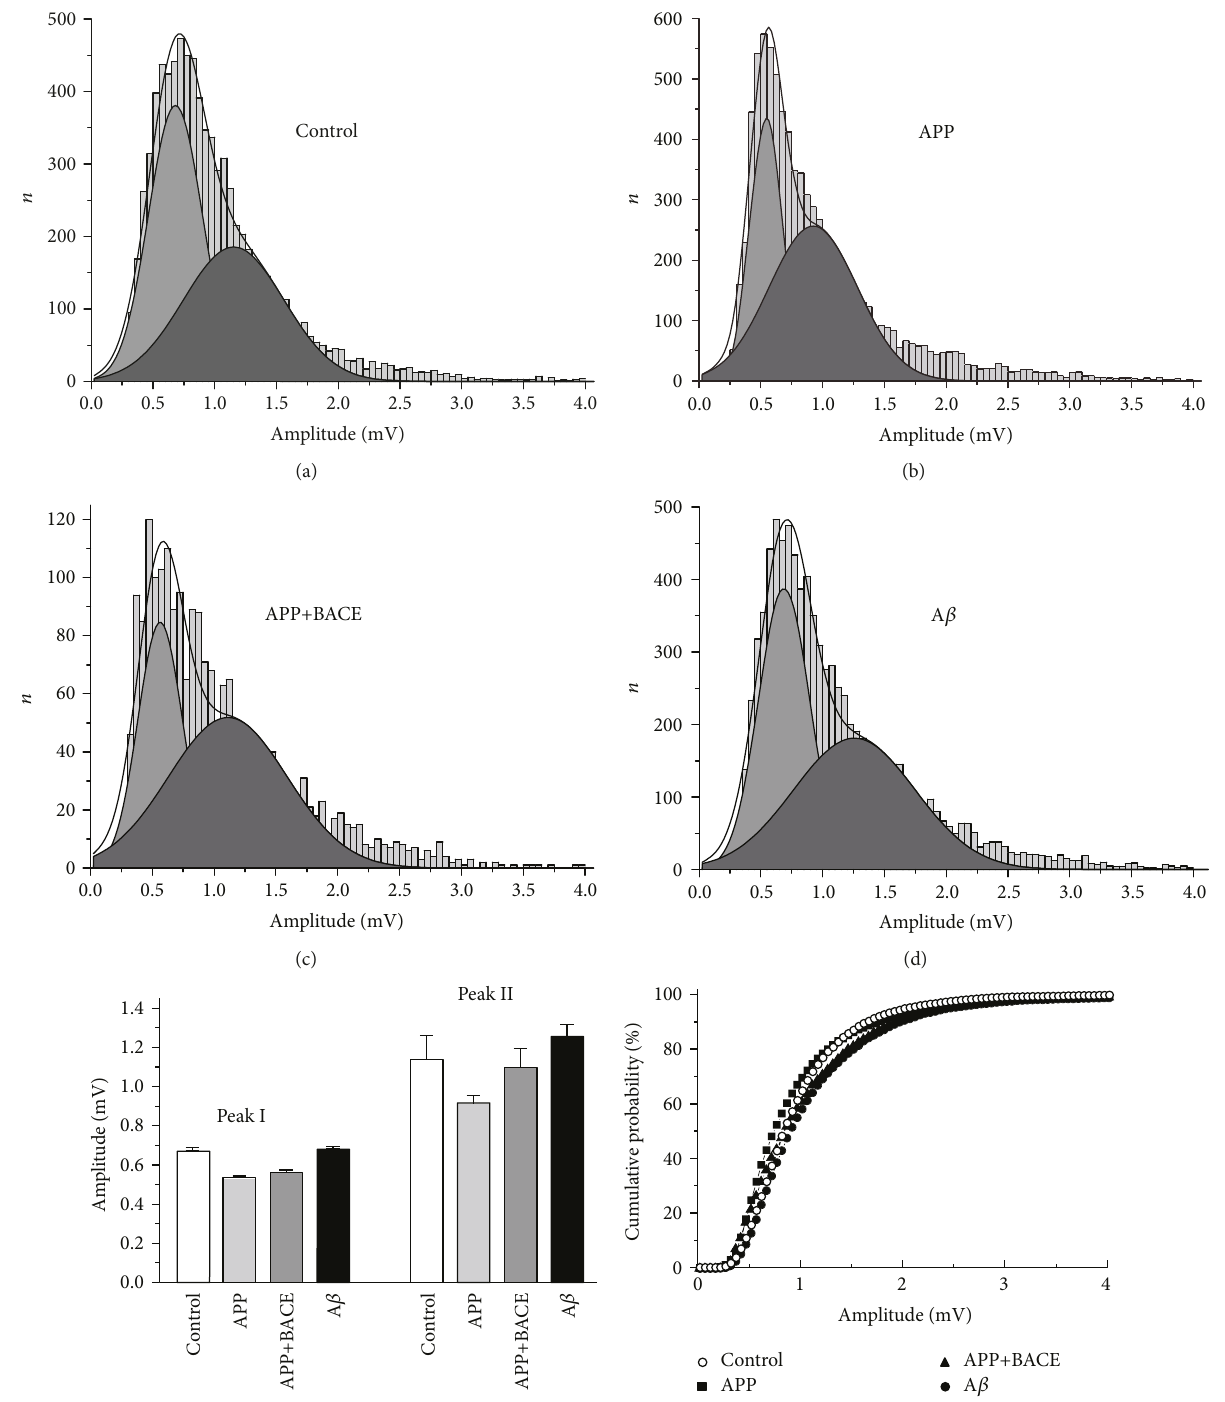
Figure 6: Distribution of mEJPs amplitudes recorded at muscle fi ber 6 and 7 neuromuscular junctions from transgenic Drosophila melanogaster larvae. (a) Control, (b) APP, (c) APP+BACE, and (d) А β lines. Amplitude histograms show similar two-peak nature of mEJPs distributions in all lines (double Gaussian fi ts are shown). (e) The average amplitude of two peaks from mEJPs amplitude distribution (a – d). (f) Cumulative histogram of the mEJPs amplitude distribution. Total mEJPs number for corresponding distributions (a – d) are included. Data are presented as mean ±